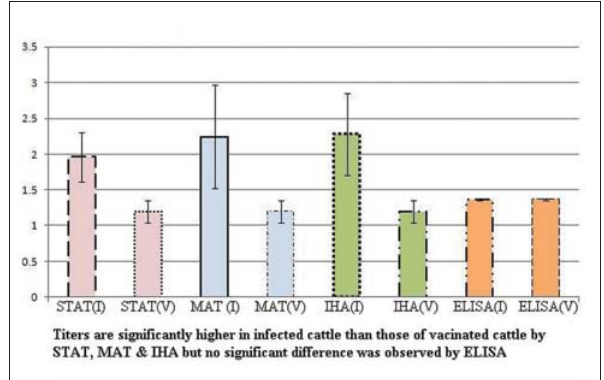
Figure-1: Antibody titers in brucellosis infected or vaccinated cattle by standard tube agglutination test, microtiter plate agglutination test, indirect hemagglutination assay test, and indirect enzyme-linked immunosorbent